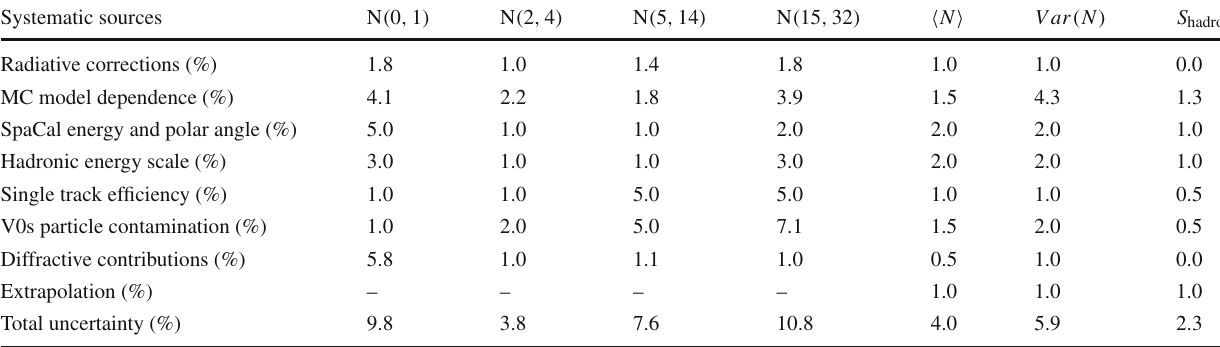
Table 2 Summary of the systematic uncertainties in this analysis Systematic